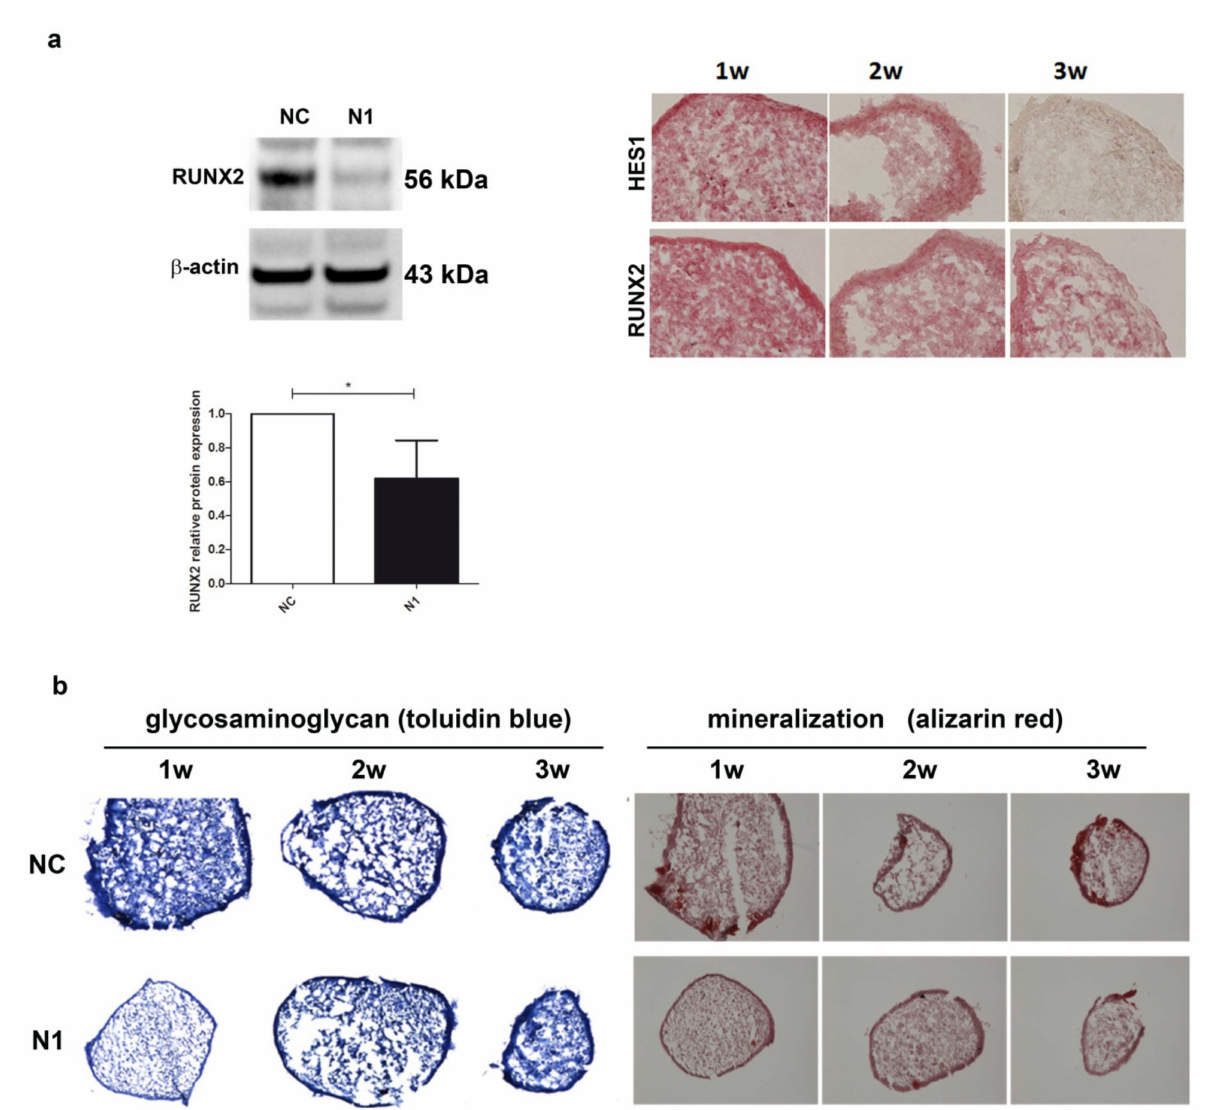
Figure 5. Effects of NOTCH1 silencing in the differentiation of chondrocytes in 3-D cultures. ( a ) NOTCH1 silencing impacts on RUNX2 expression: left, a representative Western blot indicates that RUNX2 protein is significantly reduced in NOTCH1 silenced 3-D cultures at 1 week as confirmed in the cumulative assessment shown in the lower graph ( n = 5, * p < 0.05); right, immunohistochemistry imaging of the correlated reduced expression of RUNX2 and HES1 in micromass maturation across 1–3 weeks. ( b ) NOTCH1 silencing impacts on ECM maturation. Left, GAG deposition at 1, 2, and 3 weeks as evidenced by toluidin blue staining: GAG deposition resulted delayed in N1 KD 3-D constructs. Right: Alizarin Red staining on micromasses showed a markedly reduced calcium deposition at all time points in N1 KD micromasses. All images were obtained with a NIKON Eclipse 90i microscope equipped with 10 × objective